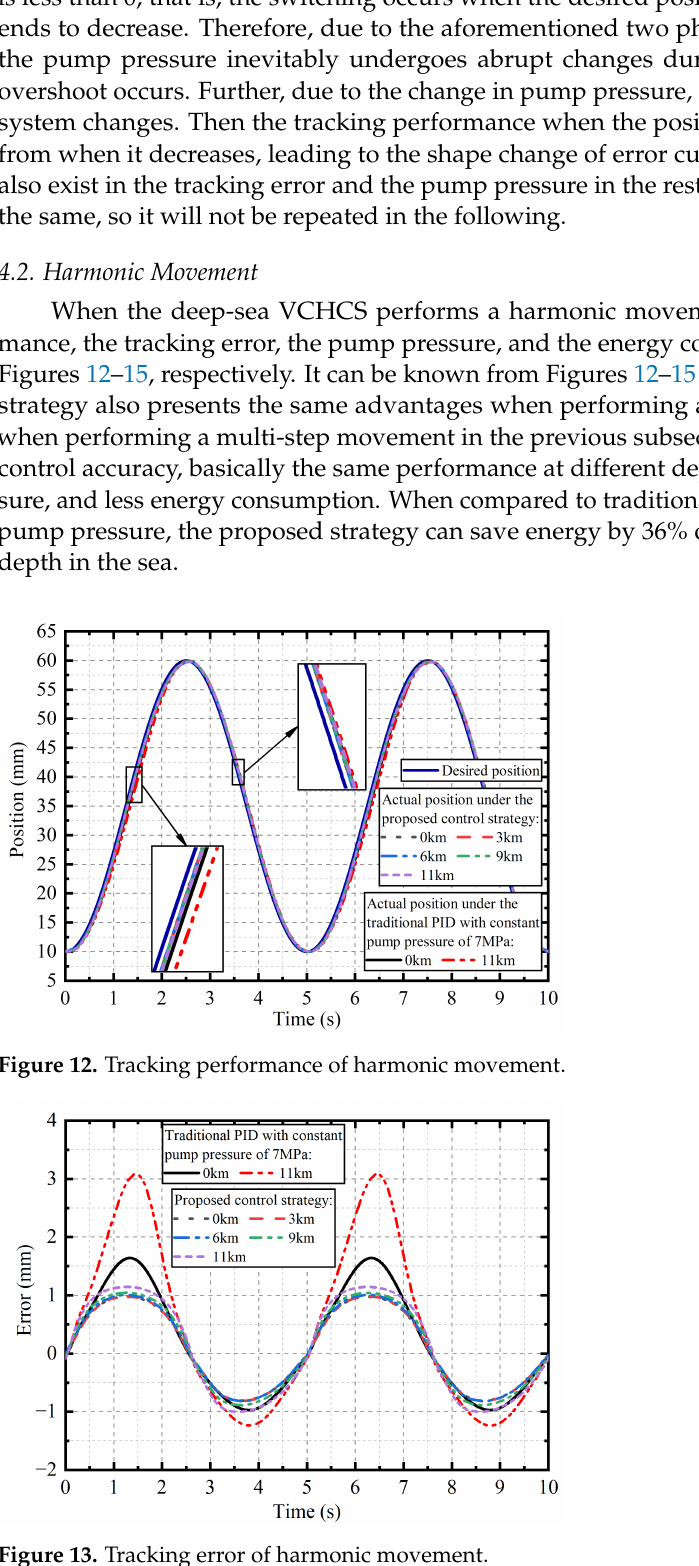
Figure 13. Tracking error of harmonic